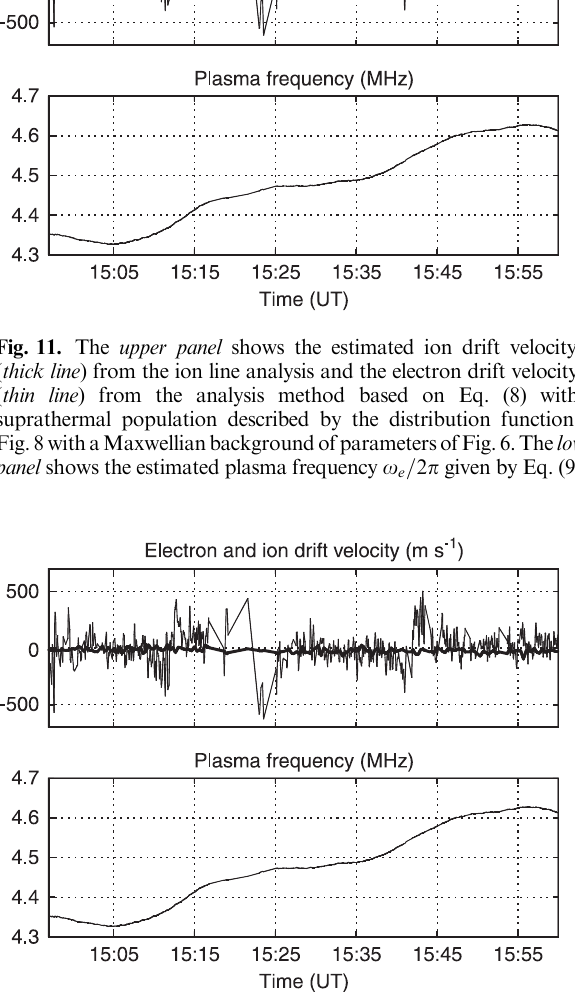
Fig. 12. The upper panel shows the estimated ion drift velocity u i ( thick line ) from the ion line analysis and the electron drift velocity u e ( thin line ) from the analysis method based on Eq. (8) with a suprathermal population described by the distribution function of Fig. 8 and a Spitzer function for the ambient electrons with parameters of Fig. 6. The lower panel shows the estimated plasma frequency x e = 2 p given by Eq. (9)